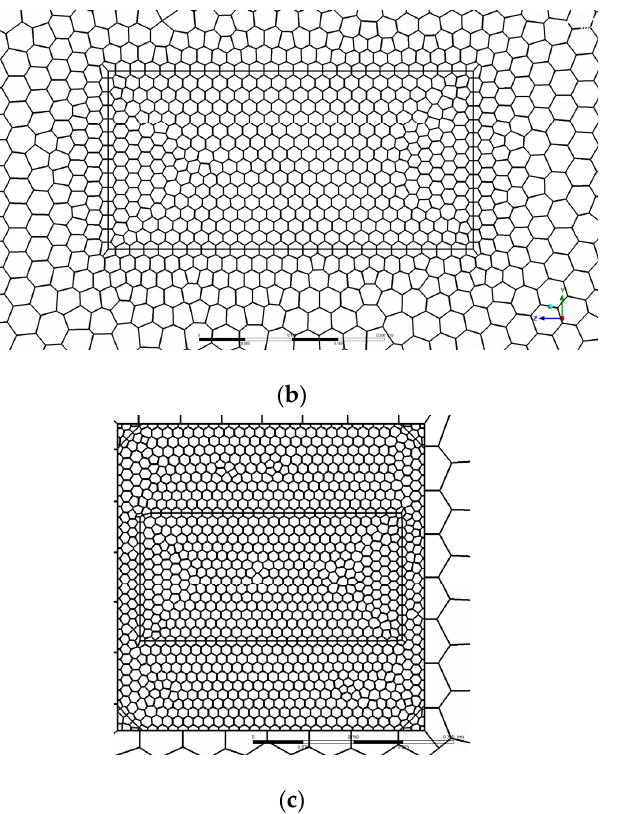
Figure 5. Mesh refinement zones ( a ), top view of the inlet diffuser mesh ( b ), side view of the exhaust diffuser ( c ).